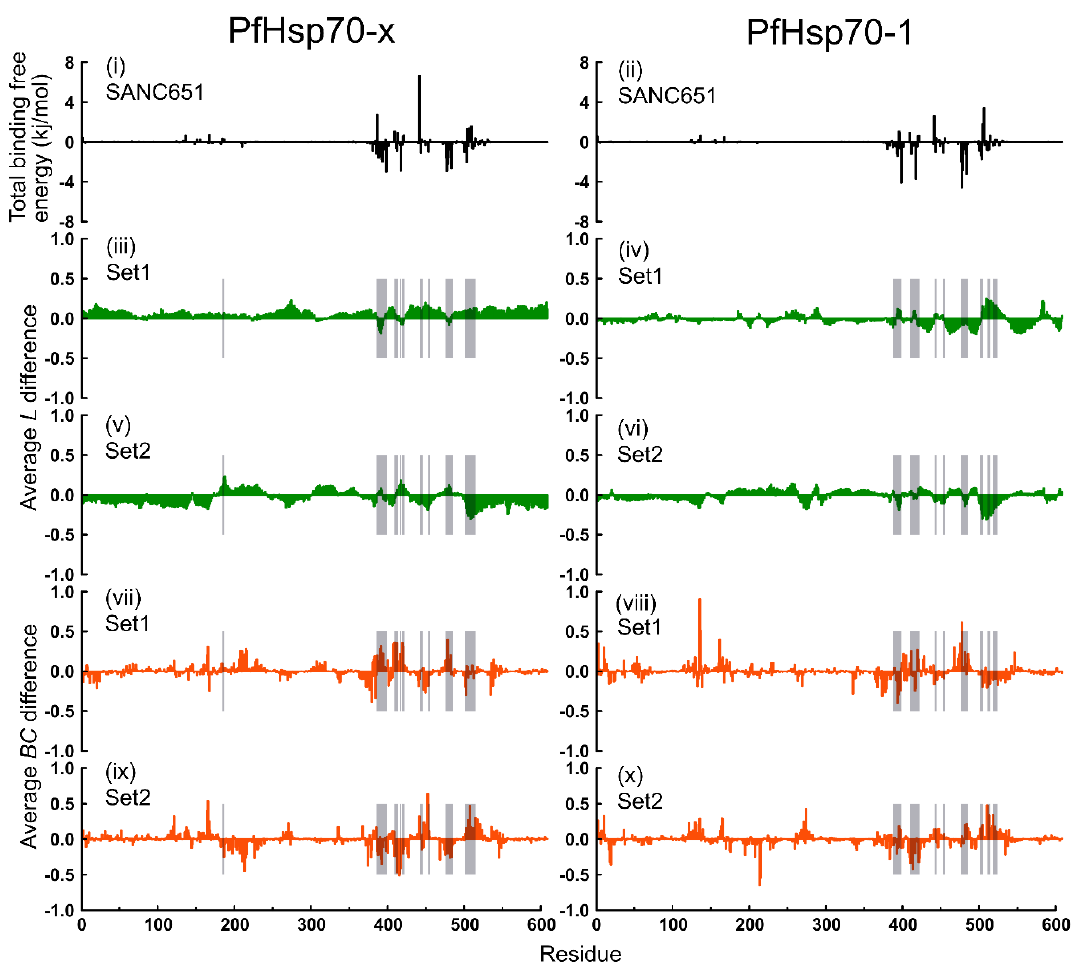
Figure 9. Computed average L and average BC per residue difference between ligand-free and SANC651-bound models (run1 and run2 on average). Top panel: Residues governing protein-ligand affinity; middle panel: Per residue average L difference; bottom panel: Per residue average BC difference.